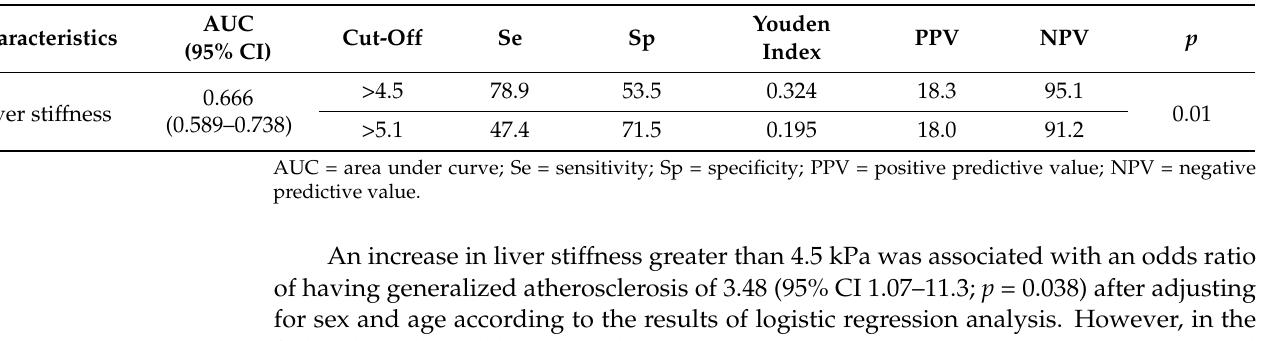
Figure 5. ROC curves demonstrating the diagnostic value of liver stiffness in relation to generalized atherosclerosis. Sub-figures ( A , B ) show the selected cut-off points that provide optimal values of sensitivity ( A ) and specificity ( B ). Table 2. Results of ROC